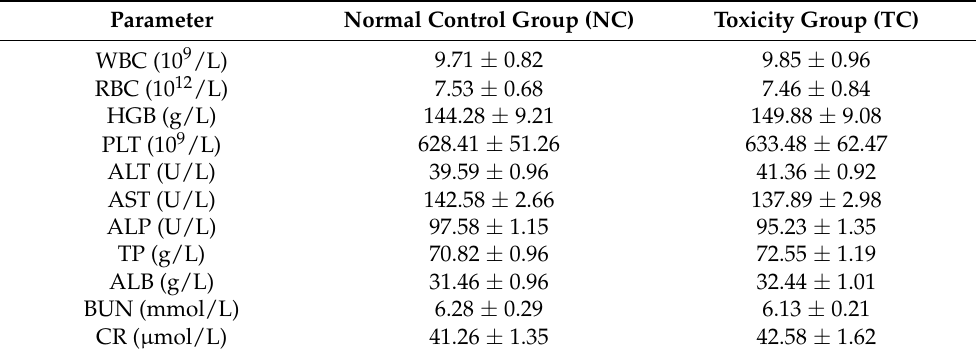
Table 9. Effects of [CrBCA 3 ] on blood routine and blood biochemical indices in sub-acute toxicity test (means ± SD, n =